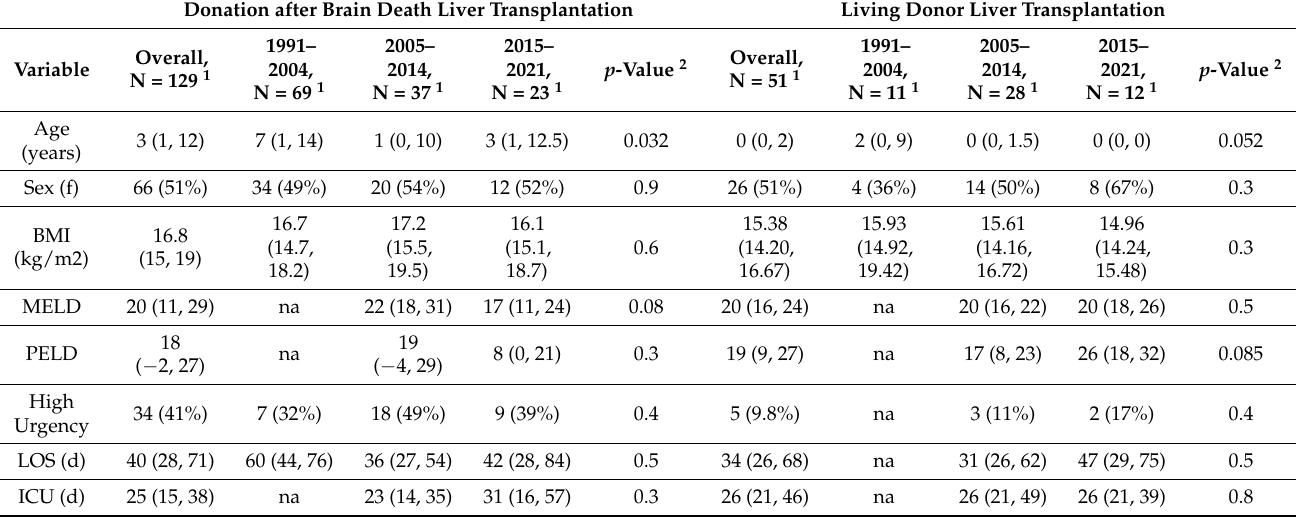
Table 1. Patient Characteristics.